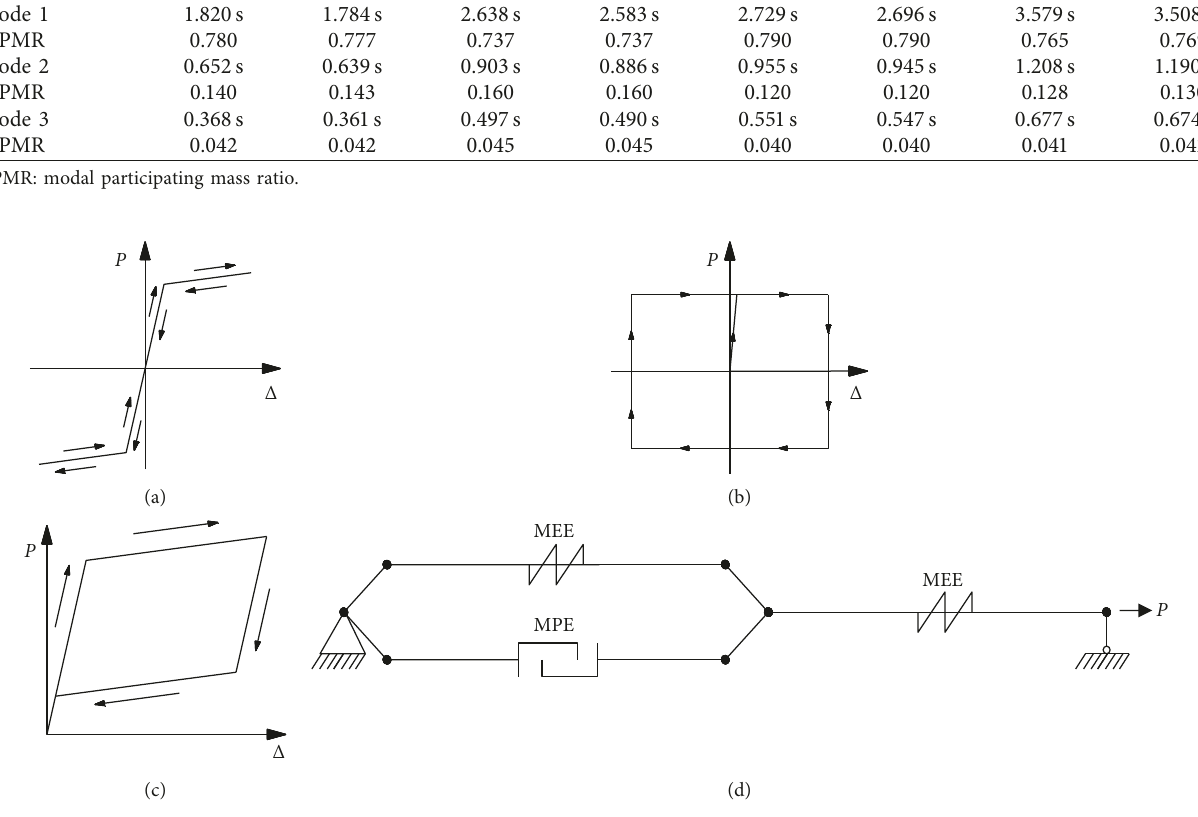
Figure 7: Simulation of SC-TOB: (a) MEE, (b) MPE, (c) target hysteresis, and (d) integrated model.